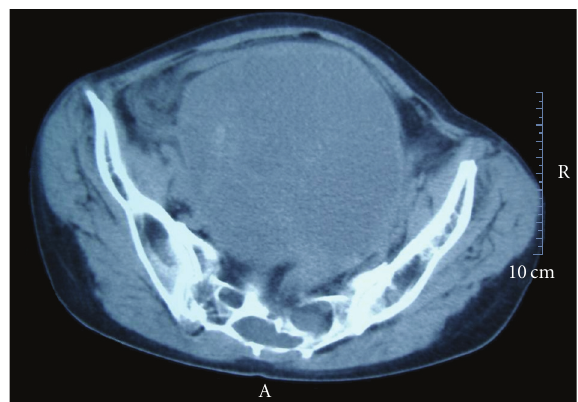
Figure 1: CT scanner image. Huge ovarian mass involving the anterior abdominal wall can be appreciated.